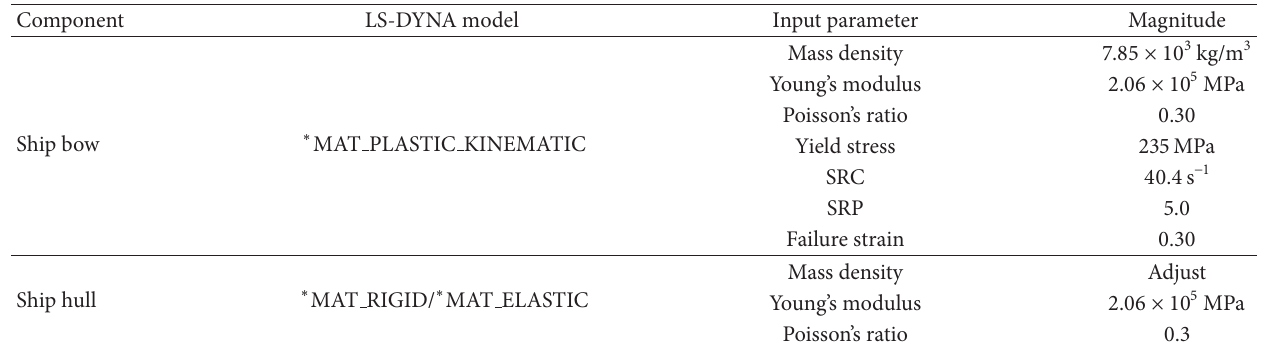
Table 2: Parameters of ship material models in numerical simulations.